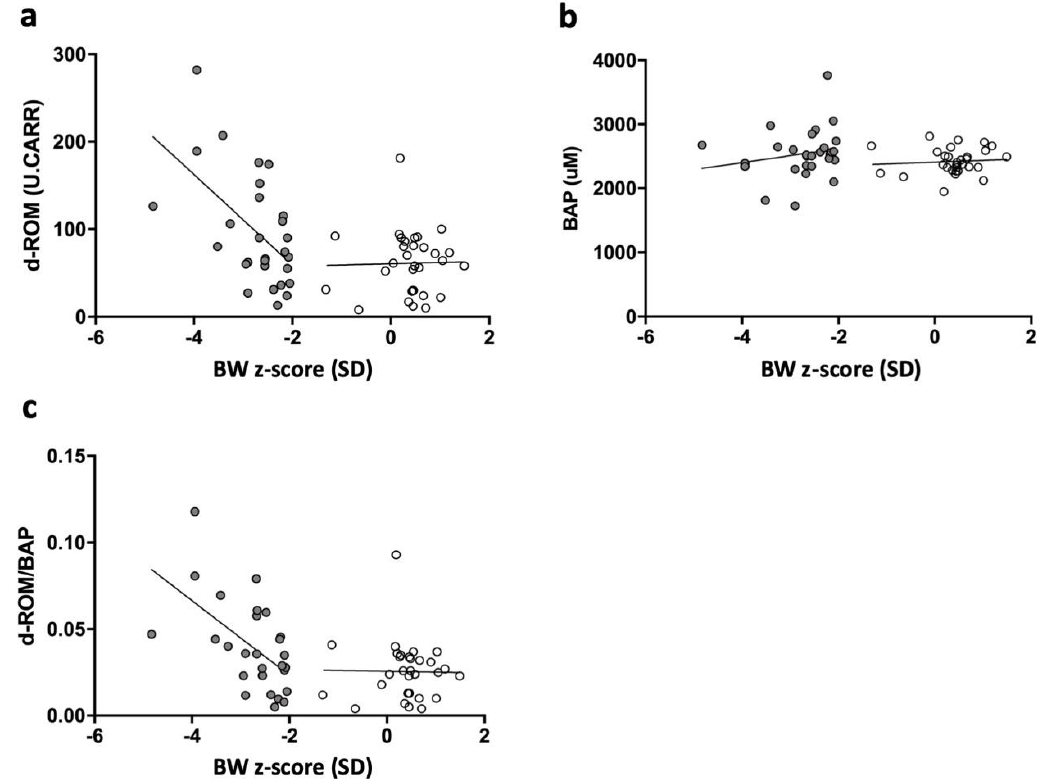
Figure 3. Correlation among serum d-ROM, BAP, d-ROM/BAP level and BW z-scores in sSGA and control infants. Serum d-ROM level and BW z-scores were significantly correlated for sSGA infants (R 2 = 0.30, p < 0.005, Figure 2a) but not for controls (R 2 = 0.00, p = 0.90, Figure 2a). No correlation was found between serum BAP level and BW z-scores in either sSGA (R 2 = 0.04, p = 0.32, Figure 2b) or control infants (R 2 = 0.01, p = 0.65, Figure 2b). Serum d-ROM/BAP level and BW z-scores were significantly correlated for sSGA infants (R 2 = 0.32, p < 0.005, Figure 2c) but not for controls (R 2 = 0.00, p = 0.93, Figure 2c). d-ROM: derivative of reactive oxidative metabolites; BAP: biological antioxidant potential; R 2 : coefficient of determination; sSGA: severe small for gestational age; SD: standard deviation; BW, birth weight. ( a ) d-ROM and BW z-score; ( b ) BAP and BW z-score; ( c ) d-ROM/BAP and BW z-score.